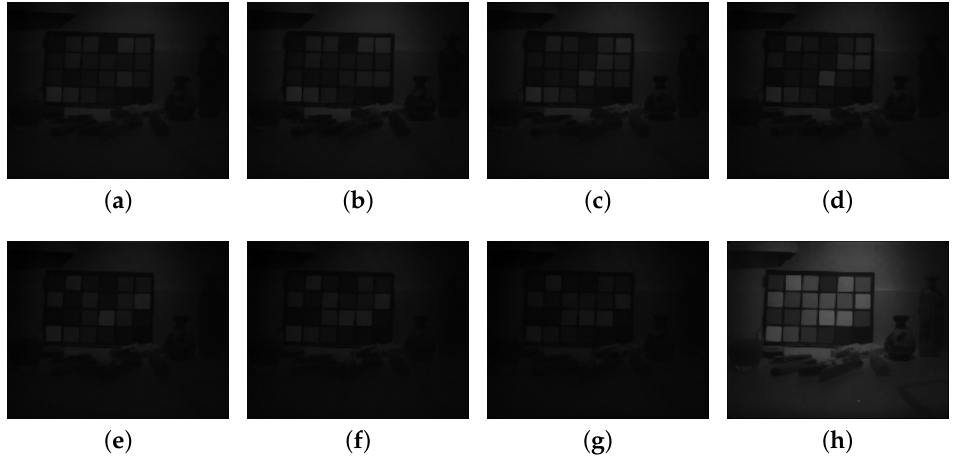
Figure 11. Demosaiced image by Miao binary tree algorithm. Channels 1 to 8 are reconstructed to provide a full resolution multispectral image. These data are encapsulated in one single tiff file for storage in Supplementary Materials. ( a ) Channel P1; ( b ) Channel P2; ( c ) Channel P3; ( d ) Channel P4; ( e ) Channel P5; ( f ) Channel P6; ( g ) Channel P7; ( h ) Channel IR. Demosaiced image is provided as a tiff file as Supplementary Materials in Figure